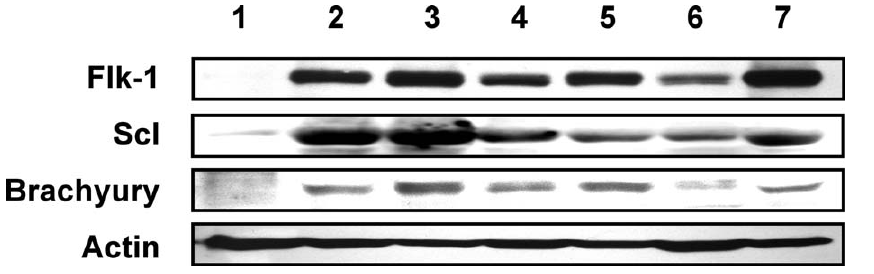
Figure 3. Western Blot Analysis Confirms Expression of Hemangioblast Markers in Tumor Cells Tumor samples (lanes 2 through 7) revealed expression of Flk-1 (VEGF receptor-2), Scl, and brachyury. Control (lane 1; normal brain) did not show expression of these proteins.